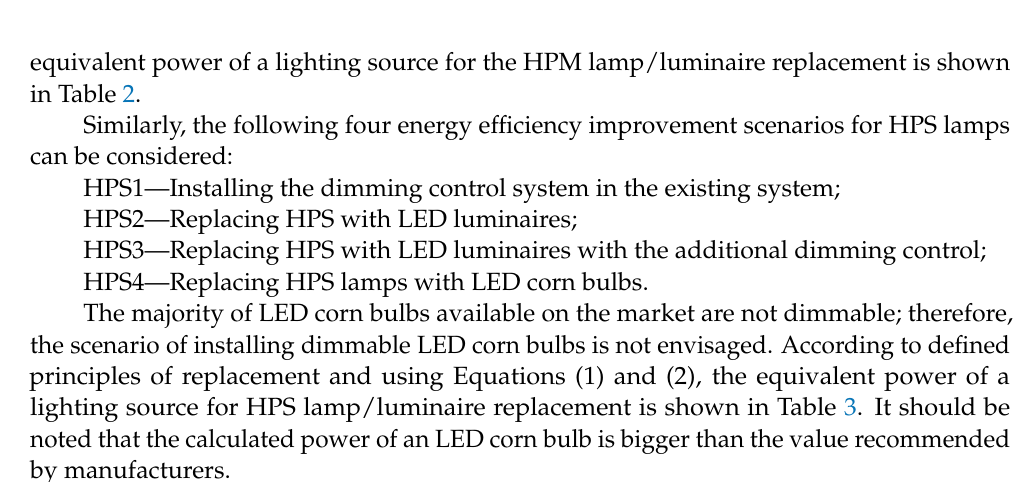
Table 3. Equivalent lighting source for different HPS lamp/luminaire replacement scenarios. Existing